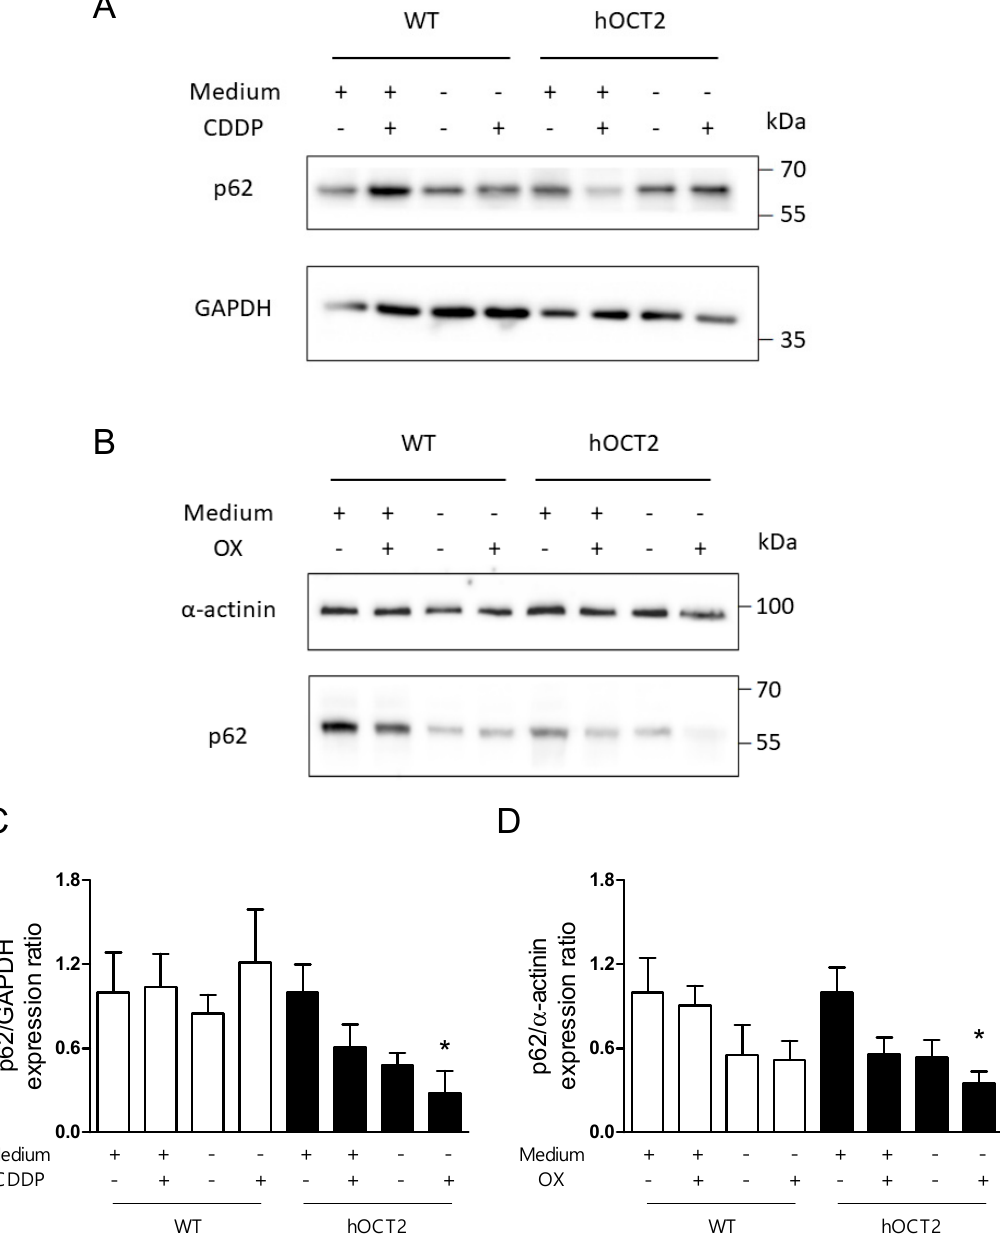
Figure 2. This figure shows activation of autophagy under CDDP or OX treatment of HEK293-WT (WT) and -hOCT2 (hOCT2) cells measured as p62 expression decrease. Cells were treated with CDDP (100 µ M, panels ( A , C )) or OX (100 µ M, panels ( B , D )) for 6 h under fed (medium +) or starvation (medium − ) conditions, as described in the Material and Methods section. The p62 expression levels were measured using Western blot analysis and GAPDH ( A , C ) or α –actinin ( B , D ) were used as loading controls. Panels ( A , B ) show representative Western blot analysis and panels ( C , D ) show the quantification as mean ± SEM of 4 independent experiments (open bars = WT cells; closed bars = hOCT2 cells). * represent a statistically significant difference between the indicated group and all the others ( p < 0.05, one way ANOVA with Tukey’s multiple comparison test). To facilitate the comparison of the effects, the expression ratio values for incubation with fed medium without CDDP or OX were set to 1 for WT and hOCT2